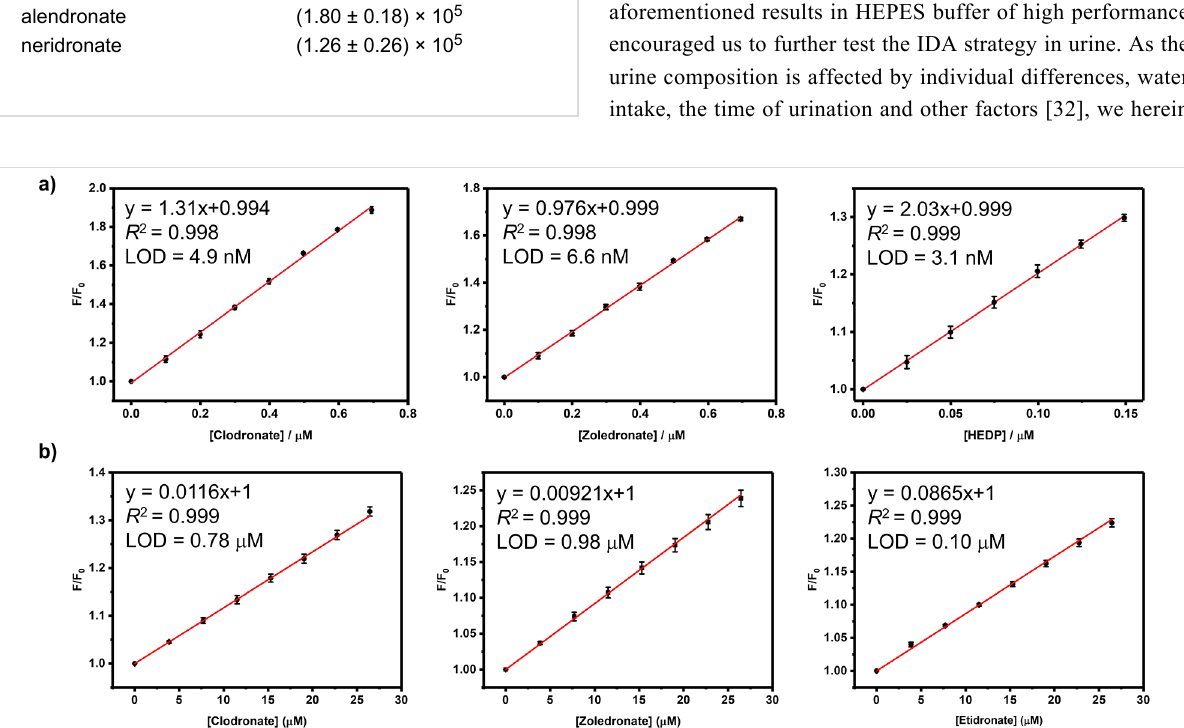
Figure 2: The set-up calibration lines of the fluorescence intensities for quantitatively determining the concentrations of clodronate, zoledronate and etidronate in (a) HEPES buffer (10 mM, pH 7.4) and (b) artificial urine at 25 °C. Error bars could not be shown if less than 0.005.